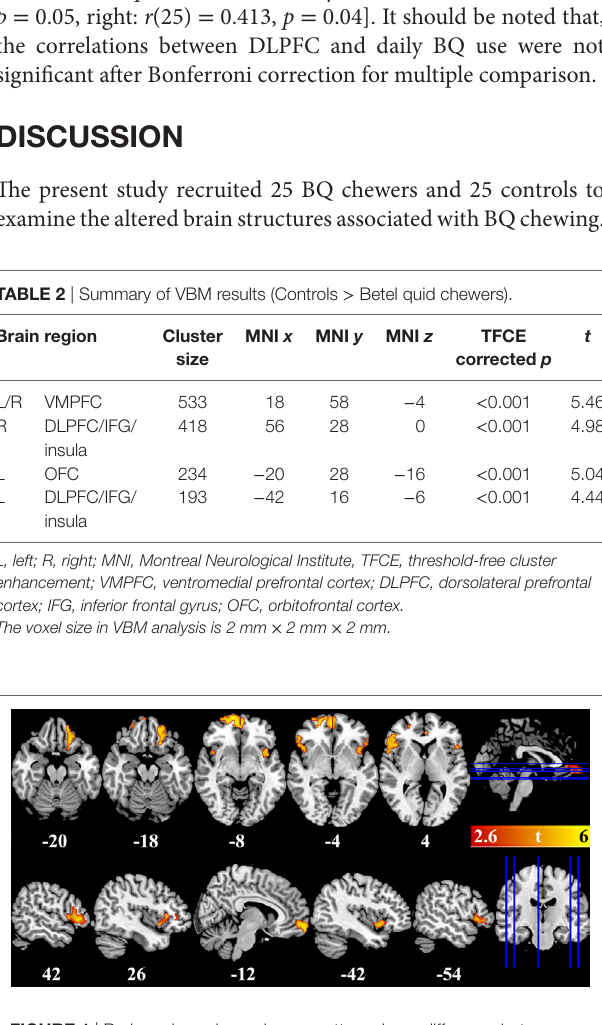
FigUre 1 | Brain regions showed gray-matter volume difference between betel quid chewers and controls. Figures are displayed in canonical (upper panel) and sagittal (lower panel) view. Numbers below each brain slices were the corresponding z (upper panel) or x (lower panel) value in the MNI space. Color bar represented the significance of the difference ( t values).